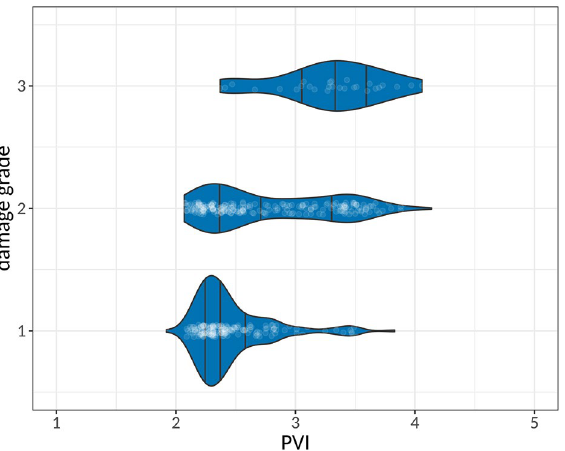
Figure 4. The relationship between the damage grade of a building and the assigned PVI. Vertical lines within the violin plots indicate the three empirical quartiles of the PVI for each damage class. The number of buildings is 167, 212, and 28 for damage grades 1, 2, and 3, respectively.